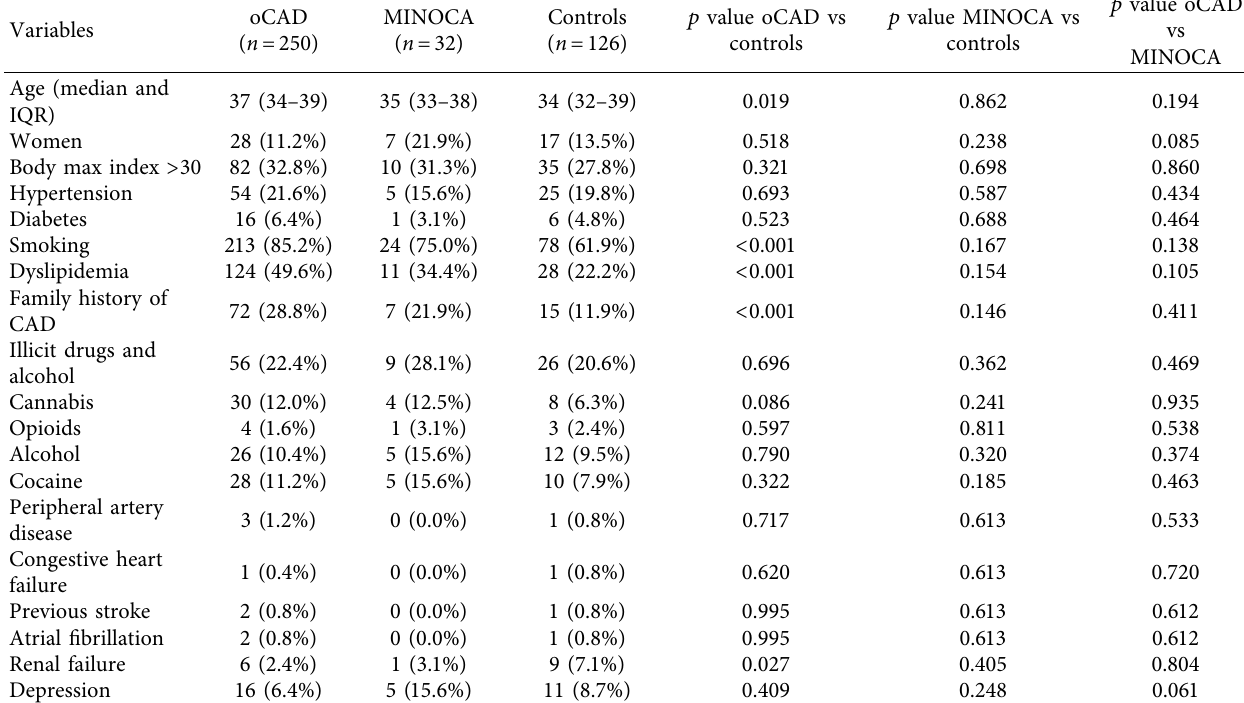
Table 1: Clinical characteristics of patients ≤ 40 years old undergoing coronary angiography.